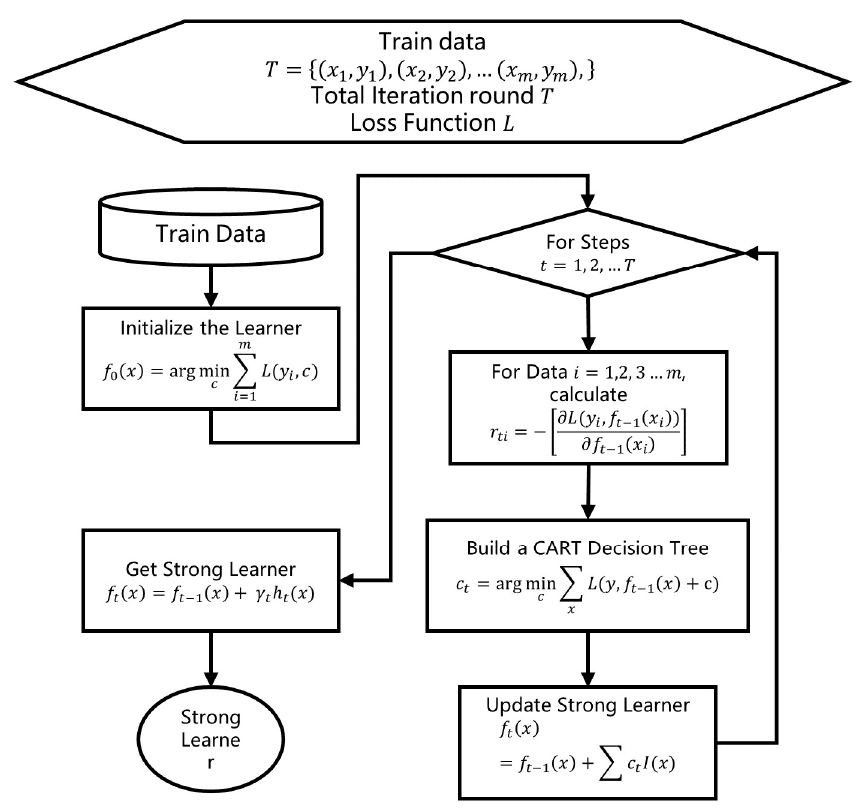
Figure 5. Training process of the gradient boosting decision tree method.